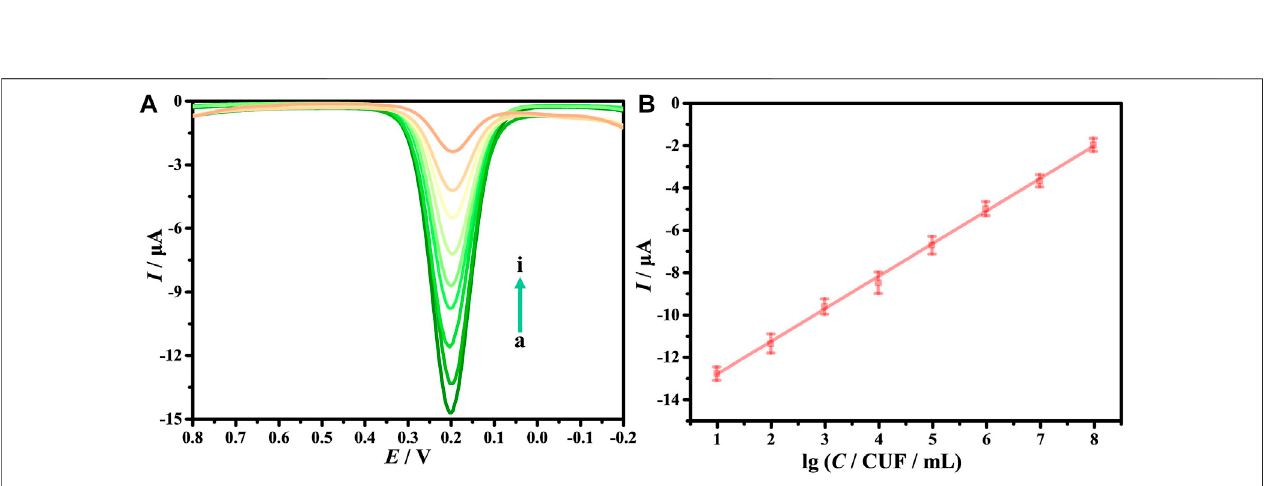
FIGURE6|(A) Differentialpulsevoltammetry(DPV)of E.coli O157:H7withdifferentconcentrations(fromatoi:0,10,10 2 ,10 3 ,10 4 ,10 5 ,10 6 ,10 7 ,10 8 CFU/ml). (B) The relationship of I pa with the lg C